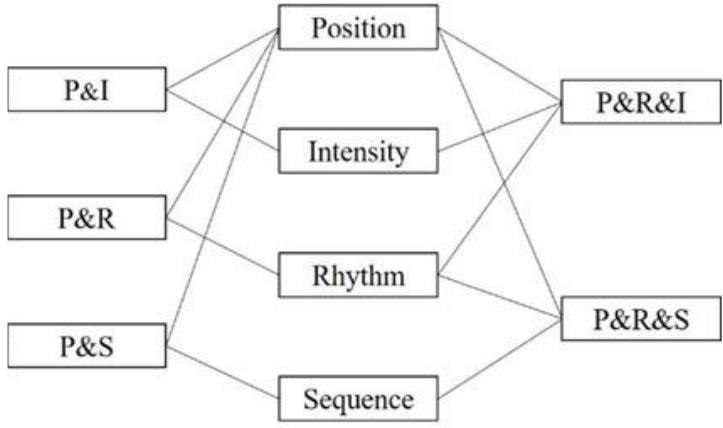
Figure 9. Schematic Diagram of Tactile Stimulation Scheme Combination.